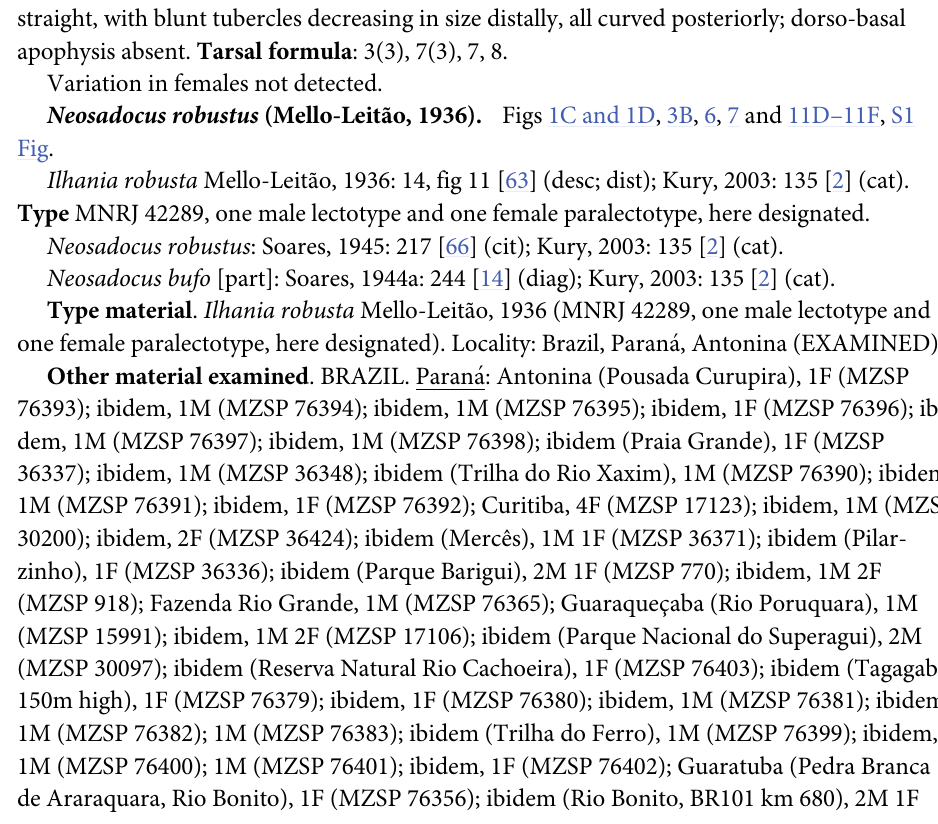
Genitalia (voucher specimen MZSP 76295; Fig 11A and 11C): Glans flattened and wrin- kled. Stylus elongated and curved, with the apex dorsally projected and with subapical ventral trichomes. Ventral process half the stylus length and ventrally concave, with various tri- chomes on the margin and on dorsal face. Ventral plate subrectangular and with a U-shaped apex; with three pairs of macrosetae A, one pair of macrosetae B, three pairs of macrosetae C, one pair of macrosetae D and two pairs of macrosetae E. Variation in males (n = 28): Dorsal scutum with length/width ratio from 0.76 to 0.92. Femur IV with 1–3 long tubercles near the dorso-basal apophysis. Dorsal scutum coloration brownish black (centroid 65) with patches between strong orange (centroid 50) and strong orange yellow (centroid 68). Leg coloration from brownish black (centroid 65) to deep orange (centroid 51). Redescription of the female ( “Bunoweyhia” variabilis female paralectotype, MNRJ 41803). Measurements : DSL : 9.5 mm. DSW : 8.0 mm. LPA : 2.5 mm. Dorsum (Fig 5A and 5C): Outline of dorsal scutum γ -type. Dorsal scutum longer than wide. Frontal hump with two paramedian tubercles. Anterior margin of carapace with four small tubercles on each side. Area III with two long paramedian conical spines encompassed by various tubercles. Free tergites II–III each with one central spine. Venter (Fig 5B): Coxa I with a proximal cluster of three prominent tubercles and a distal cluster of two prominent tubercles. Coxa II and stigmatic area tuberculate. Pedipalp : Femur smooth. Tibial setation : prolateral Ii(Ii) and retrolateral IIi. Tarsal seta- tion : prolateral IiIiiiii and retrolateral IIiii. Legs (Fig 5D and 5E show leg IV): Coxa III smooth. Coxa IV shorter than in males; proapi- cal apophysis absent. Trochanter IV without a prolateral apophysis; retroventral tubercle and prolateral proximal cluster of small setae both absent. Femora II–III tuberculate. Femur IV straight, with blunt tubercles decreasing in size distally, all curved posteriorly; dorso-basal apophysis absent. Tarsal formula : 3(3), 7(3), 7, 8. Variation in females not detected. Neosadocus robustus (Mello-Leit ã o, 1936). Figs 1C and 1D, 3B, 6, 7 and 11D–11F, S1 Fig. Ilhania robusta Mello-Leit ã o, 1936: 14, fig 11 [63] (desc; dist); Kury, 2003: 135 [2] (cat). Type MNRJ 42289, one male lectotype and one female paralectotype, here designated. Neosadocus robustus : Soares, 1945: 217 [66] (cit); Kury, 2003: 135 [2] (cat). Neosadocus bufo [part]: Soares, 1944a: 244 [14] (diag); Kury, 2003: 135 [2] (cat). Type material . Ilhania robusta Mello-Leit ã o, 1936 (MNRJ 42289, one male lectotype and one female paralectotype, here designated). Locality: Brazil, Parana´, Antonina (EXAMINED). Other material examined . BRAZIL. Parana´: Antonina (Pousada Curupira), 1F (MZSP 76393); ibidem, 1M (MZSP 76394); ibidem, 1M (MZSP 76395); ibidem, 1F (MZSP 76396);